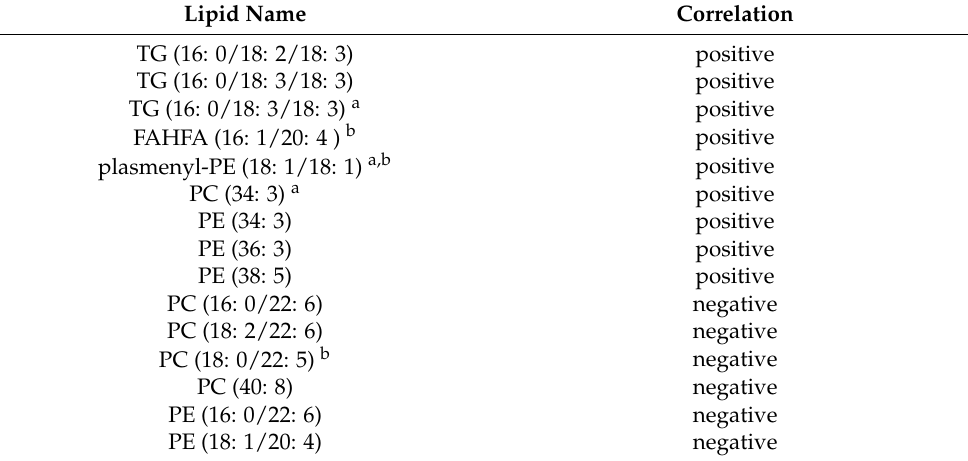
Table 4. The significantly changed lipid species correlating with A1 → C3 → D4 → B2 pattern, based on Spearman correlation coefficients >0.5; B2, mycotoxin-exposed NAFLD group; C3, silymarin-treated NAFLD group; D4, mycotoxin plus silymarin-exposed NAFLD group; A1, control NAFLD group. Lipid Name Correlation